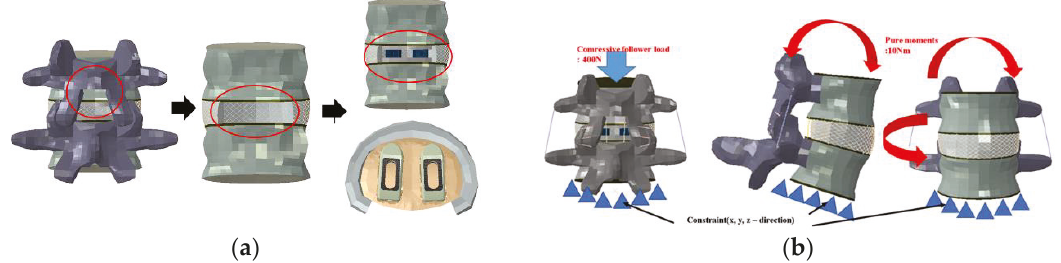
Figure 4. ( a ) Implementation of lumbar treatment model, ( b ) Physiological loading applied to the developed lumbar treatment model.